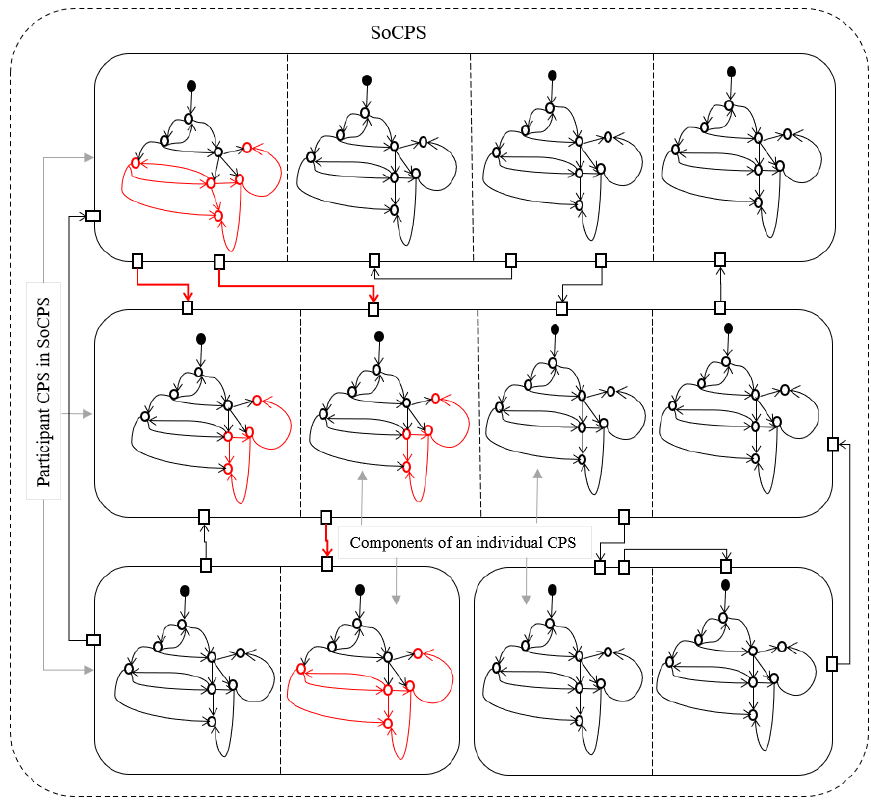
Figure 2. Fault propagation and traceability in SoCPS.